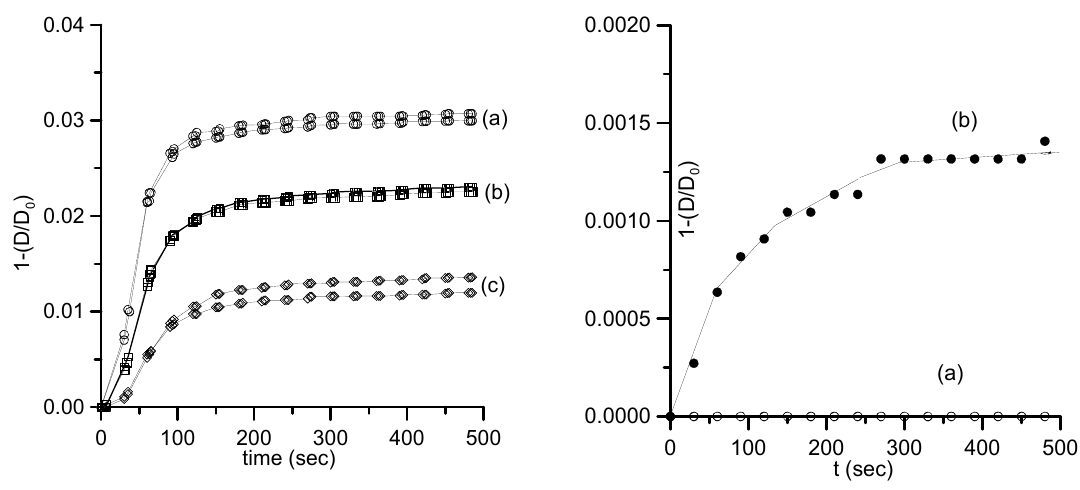
Figure 7. Representation of 1 − (D/D ) as a function of time for the aerosil/(1,3 0 butanedioldimethacrylate + biphenol A dimethacrylate) system in the presence of 1.62 mg PMMA/0.5 g aerosil: the platelet system (a); the aggregates (b), and the settled whole sediment (c). (The (a), (b) and (c) curves refer to duplicate experiments) ( left ). Representation of the polymerization shrinkage 1-(D/D ) determined for crystals lying on 0 the basal (a) or on the lateral face (b) ( right